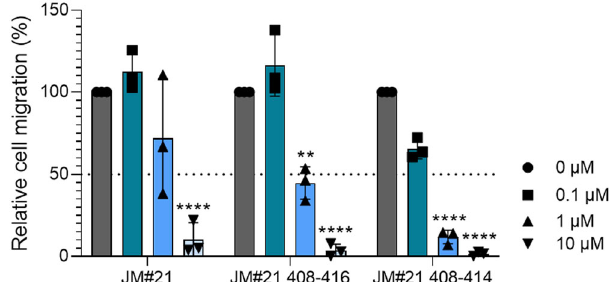
Fig. 7 Truncated JM#21 variants dose-dependently inhibit CXCL12 induced migration of cancer T cells. The migration of SupT1 cells towards a 100 ng/ml CXCL12 gradient in a transwell was tested in the presence of indicated concentrations of peptides. After 4 h amounts of migrated cells were determined by CellTiterGlo assay and normalized to values obtained for the PBS control. Shown are values derived from three individual experiments performed in triplicates ± SEM. **** p < 0.0001, ** p < 0.01 (one-way ANOVA with Dunnett ’ s multiple comparison test, compared to PBS